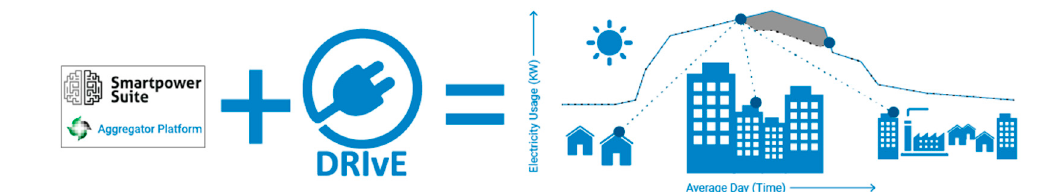
Figure 3. DRIvE flexibility optimization.